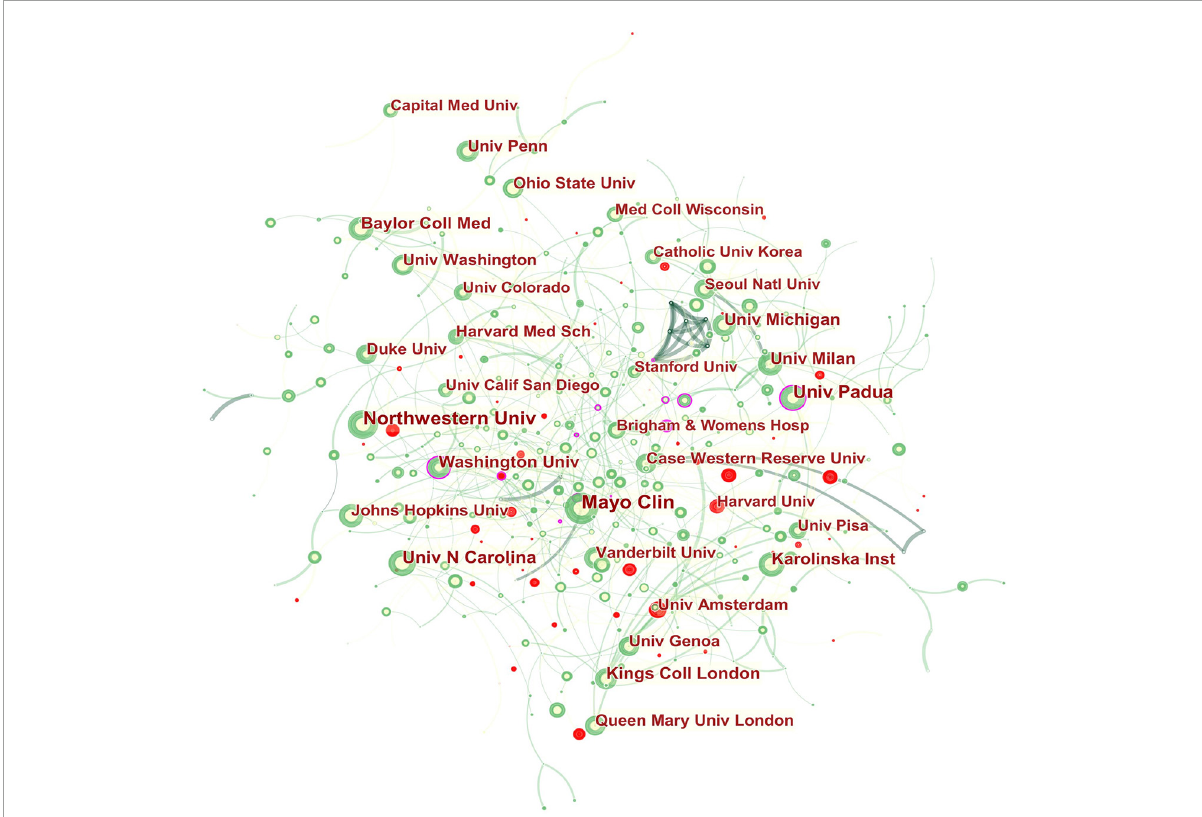
FIGURE3 Network of institutions engaged in GERD research. In the network map, a node represents an institution. The volume of each node (institution) corresponds to the number of publications, and connecting lines between nodes indicate bidirectional relationships between the institutions; the thickness of the line indicates the strength of the bidirectional collaborative relationships. Isolated institutions lack any collaboration. A node with a high betweenness centrality links two or more large groups of nodes. A node with a high betweenness centrality score exerts a strong influence on the network. A purple trim indicates a high betweenness centrality. Red tree rings indicate bursts of citation. The greater the thickness of the red tree rings, the greater the bursts for the corresponding node.